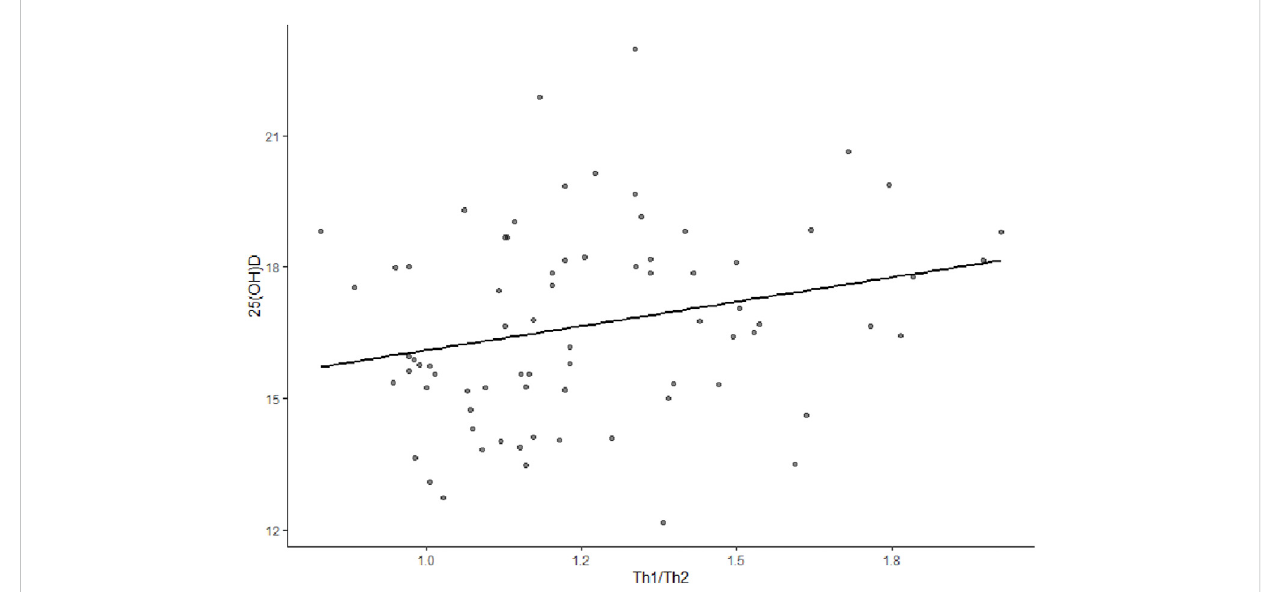
CorrelationanalysisbetweenTh1/Th2andvitDlevelinearlyCOPD.Ther(correlationcoef fi cient)was0.27( p =0.02),indicatingthatTh1/Th2andvit D were positively